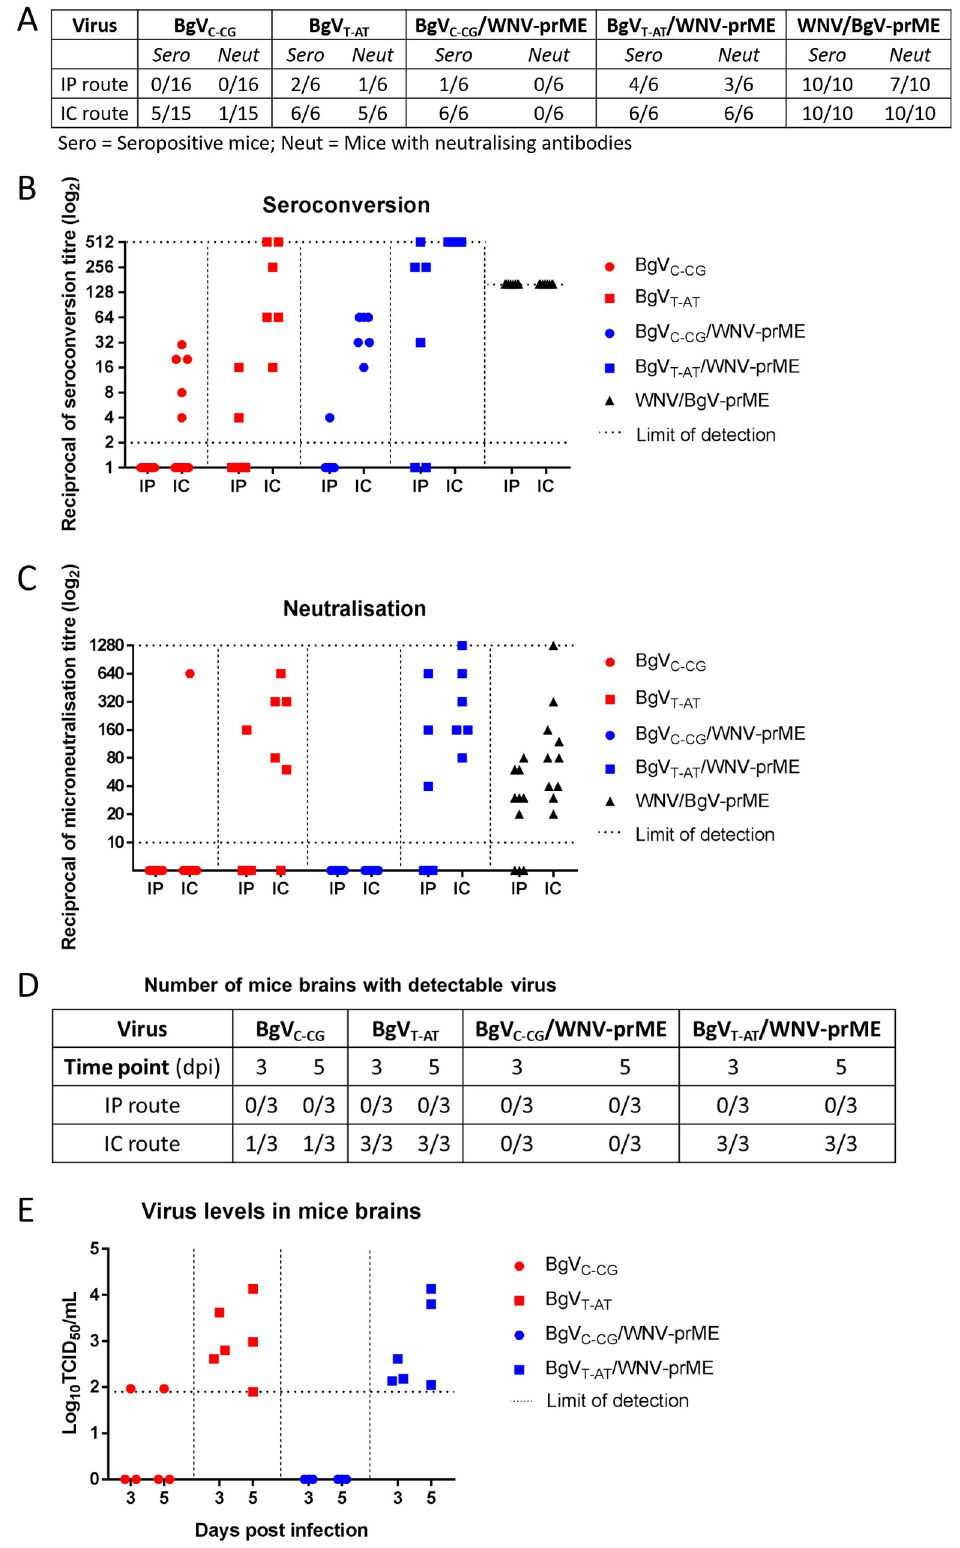
Fig 5. A. Summary of seropositive mice inoculated with BgV-derived viruses and mice with neutralising antibodies. Seroconversion was determined by fixed-cell ELISA using doubling dilutions of sera on BgV infected and fixed